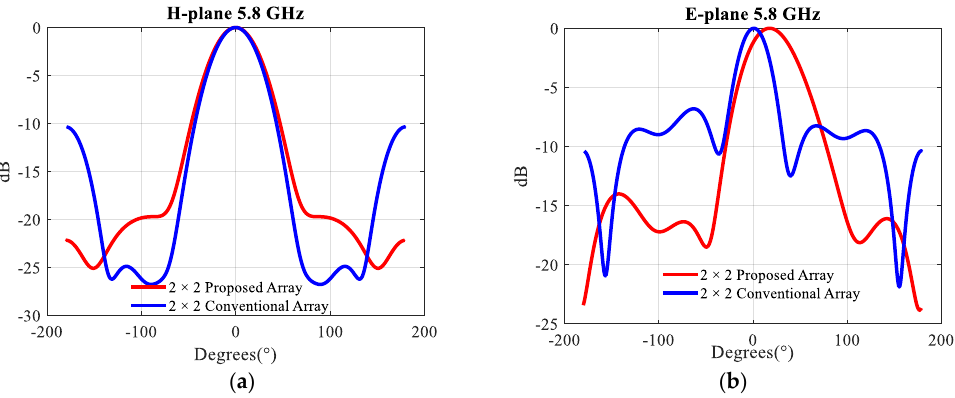
Figure 15. Simulated radiation patterns in ( a ) the H-plane, ( b ) the E-plane of the 2 × 2 conventional and proposed arrays at 5.8